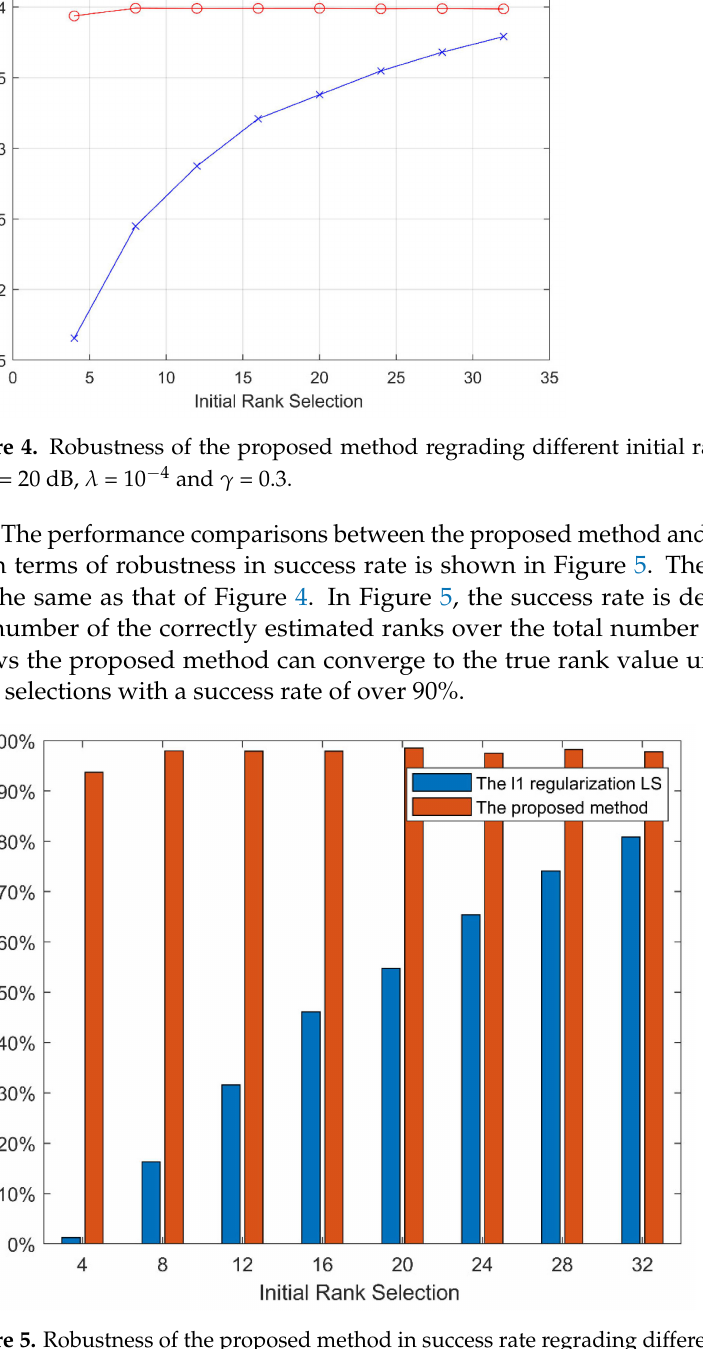
Figure 5. Robustness of the proposed method in success rate regrading different values of initial rank with R = 4, SNR = 20 dB, λ = 10 − 4 and γ =